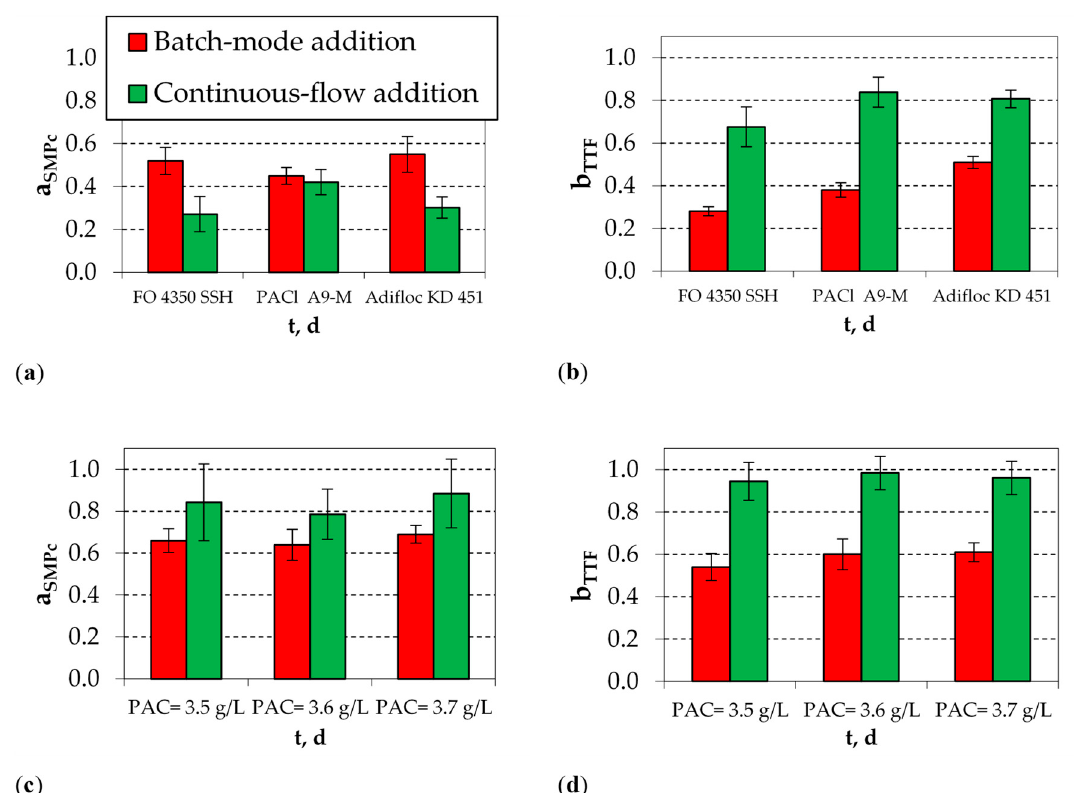
Figure 7. Average values of (a) a SMPc and (b) b TTF , after batch-mode and continuous-flow addition of the optimal coagulation agents FO 4350 SSH (10 mg / L), PACl A9-M (100 mg Al / L), and Adifloc KD 451 the optimal coagulation agents FO 4350 SSH (10 mg/L), PACl A9-M (100 mg Al/L), and Adifloc KD (10 mg / L); and ( c ) a SMPc and ( d ) b TTF , after batch-mode and continuous-flow addition of the optimal 451 (10 mg/L); and (c) a SMPc and (d) b TTF , after batch-mode and continuous-flow addition of the optimal PAC concentrations (3.5, 3.6, and 3.7 g / PAC concentrations (3.5, 3.6, and 3.7 g/L).